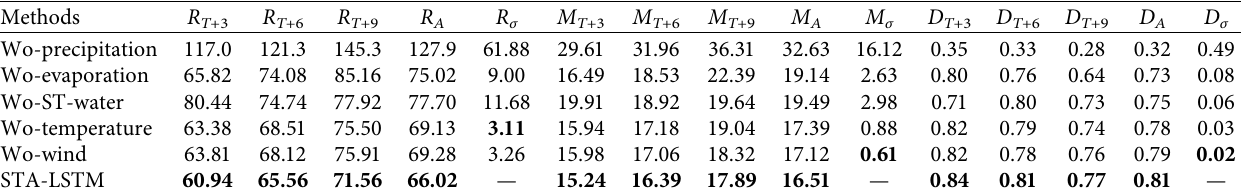
Table 2: Comparison experiments on Lech dataset to show sensibility of different input hydrological features, where Wo- refers to operation of eliminating one specifical hydrological feature, ST-Water is short for hydrological feature of soil tension water, subscripts A and σ represent mean value and bias value respectively, R , M and D represents measurements of RMSE, MAPE, and DC, respectively. Note that bold texts indicate best performance among comparative methods. We define unit for M as